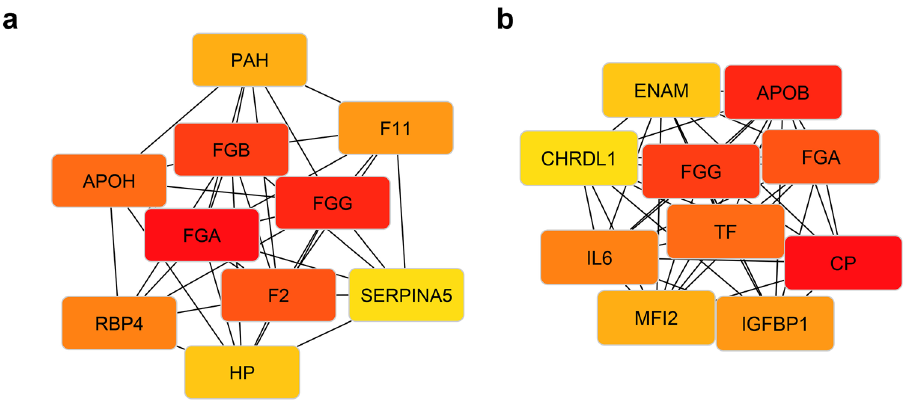
Figure 3. Top 10 highest score hub genes for Cluster 1 ( a ) and Cluster 2 ( b ). The edges of the graph show interactions between nodes. Red color corresponds to a higher MCC score, and thus of greater importance in the network of interactions. Yellow color corresponds to a lower MCC score, and thus of lower importance in the network of